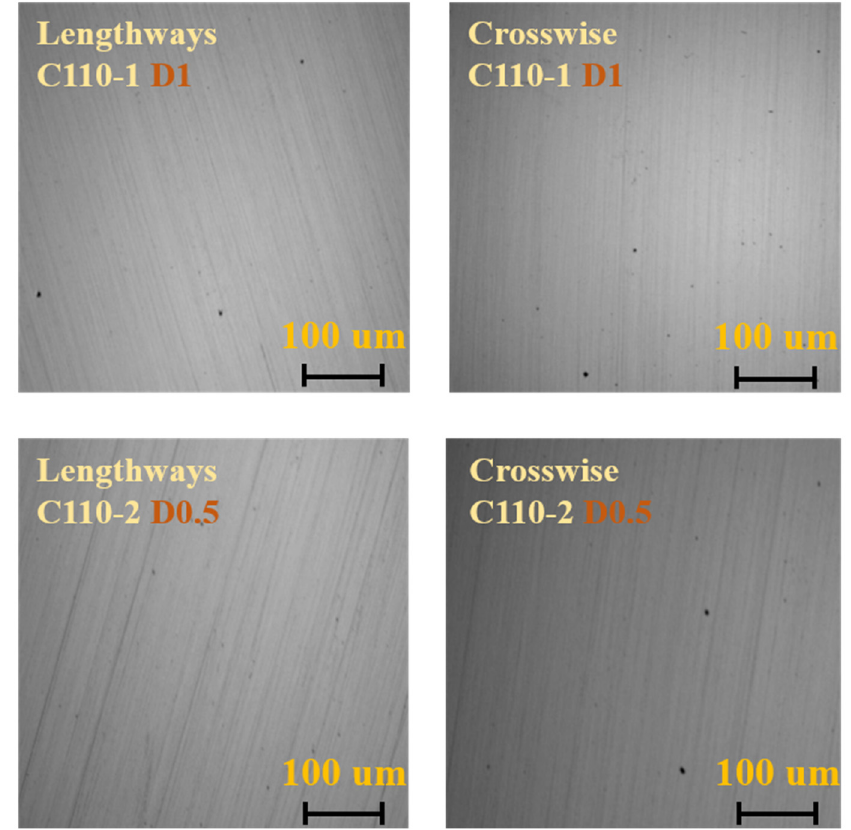
Figure 7. Non-metallic inclusions in C110-1 and C110-2.